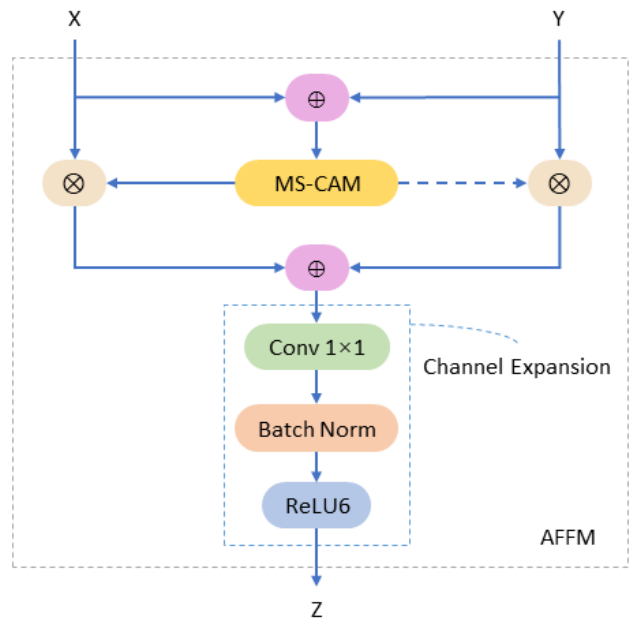
Figure 6. The main structure of the AFFM.